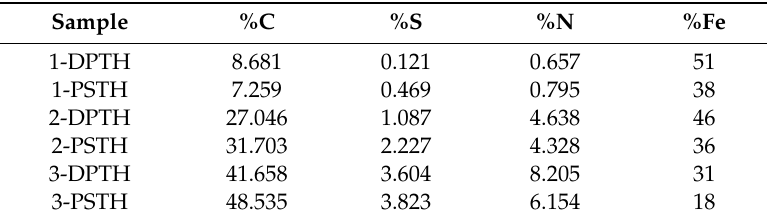
Table 2. Elemental composition of the synthesized